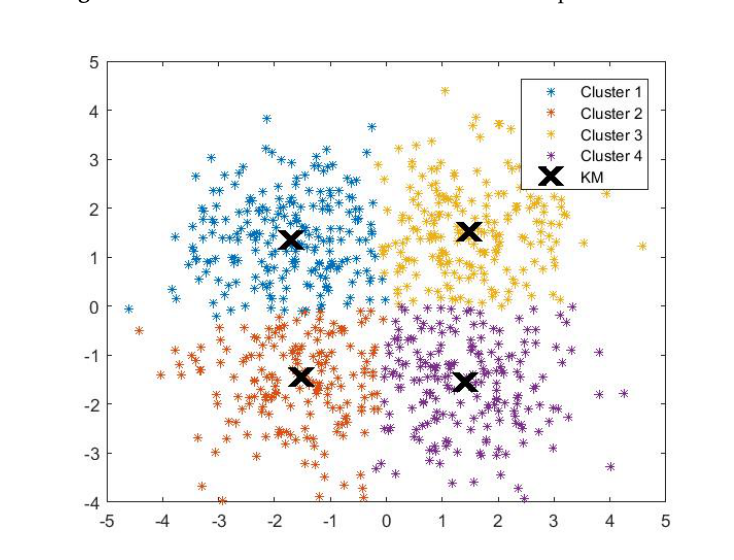
Figure 7. Illustration of order selection under channel support matrix.